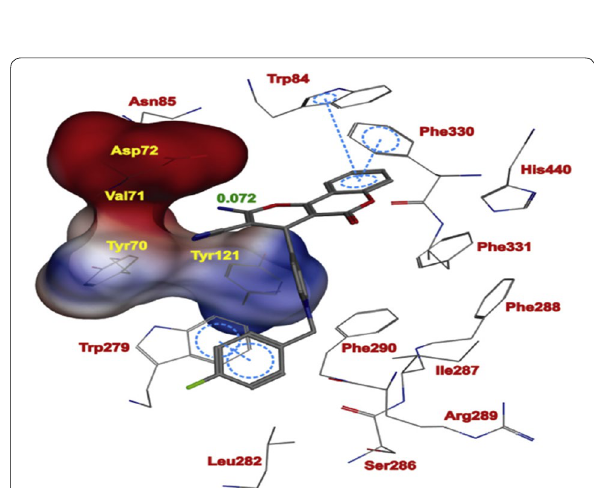
Fig. 24 A representative model for interaction of compound C16 and the AChE [46]